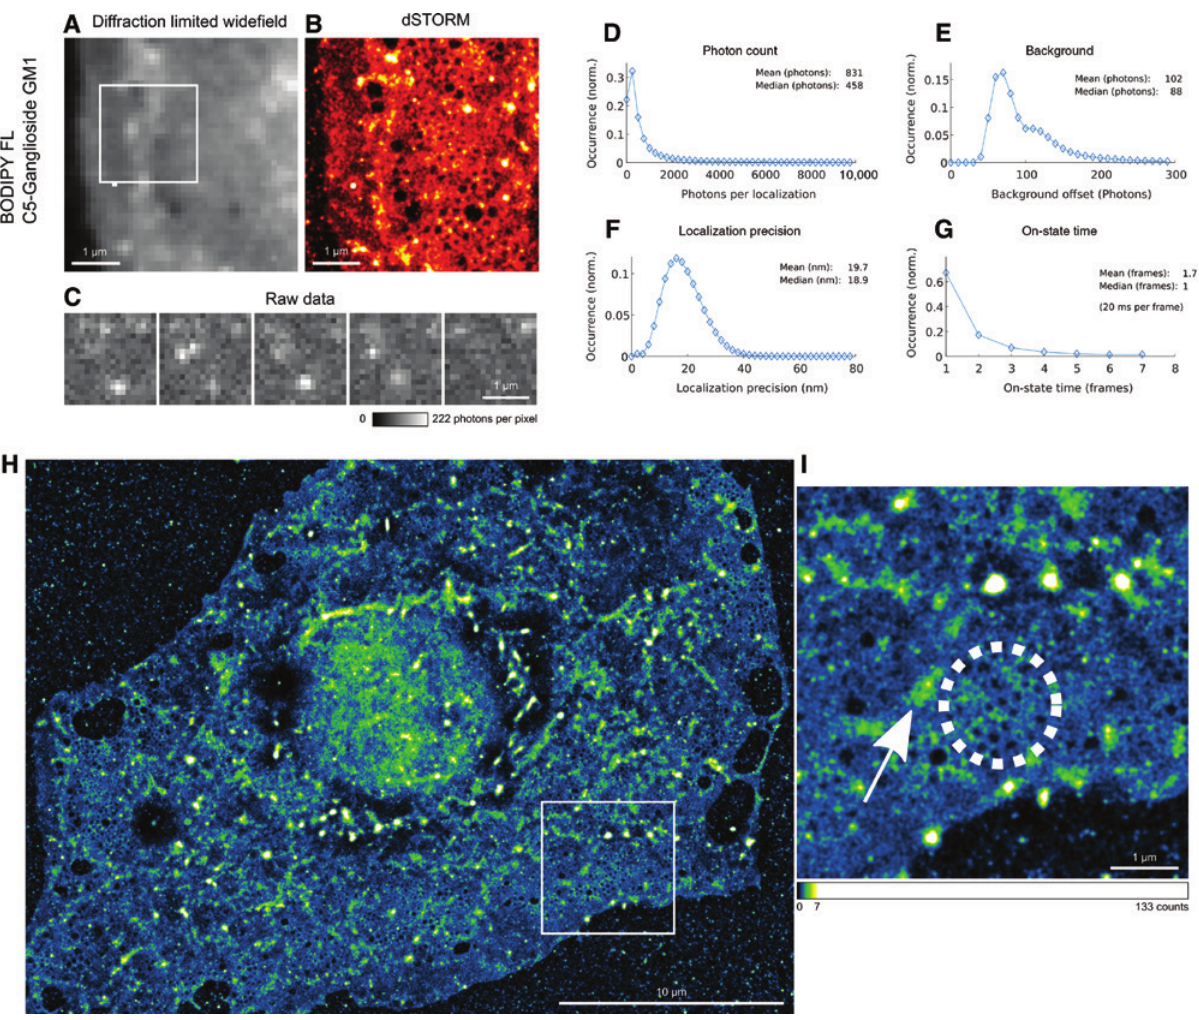
Figure 5: Bodipy FL C5-ganglioside GM1 visualizes lipid rafts and fenestrations. (A) Diffraction limited and (B) dSTORM images of BodipyGM1-stained mouse LSECs show the resolution enhancement in the dSTORM image, where membrane fenestrations become visible. (C) Representative raw data of photo-switching BodipyGM1 in subsequent frames of the area indicated by the box in (A). (D–G) show the single molecule (Bodipy) localization statistics as photon counts per localization, background, localization precision and on-state-lifetime histograms. (H) An entire LSEC stained with BodipyGM1 processed with a high-contrast look-up table. Blue indicates low-density BodipyGM1 staining, while green to white indicates high-density BodipyGM1 staining. (I) The inset from (H) shows the proximity of a sieve plate (encircled with white dashes) to a putative lipid raft (indicated by a white